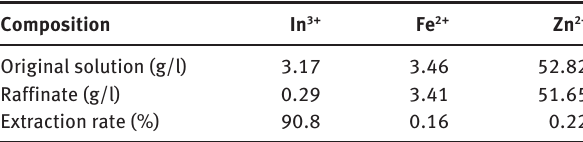
Table 2 The chemical composition of the original solution and the raffinate after microreactor extraction.